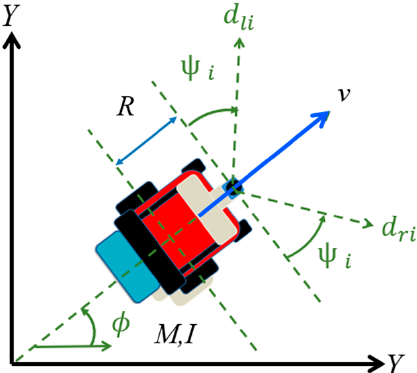
Figure 2. The block diagram of the reference model control for the developed i E-Wheelchair.